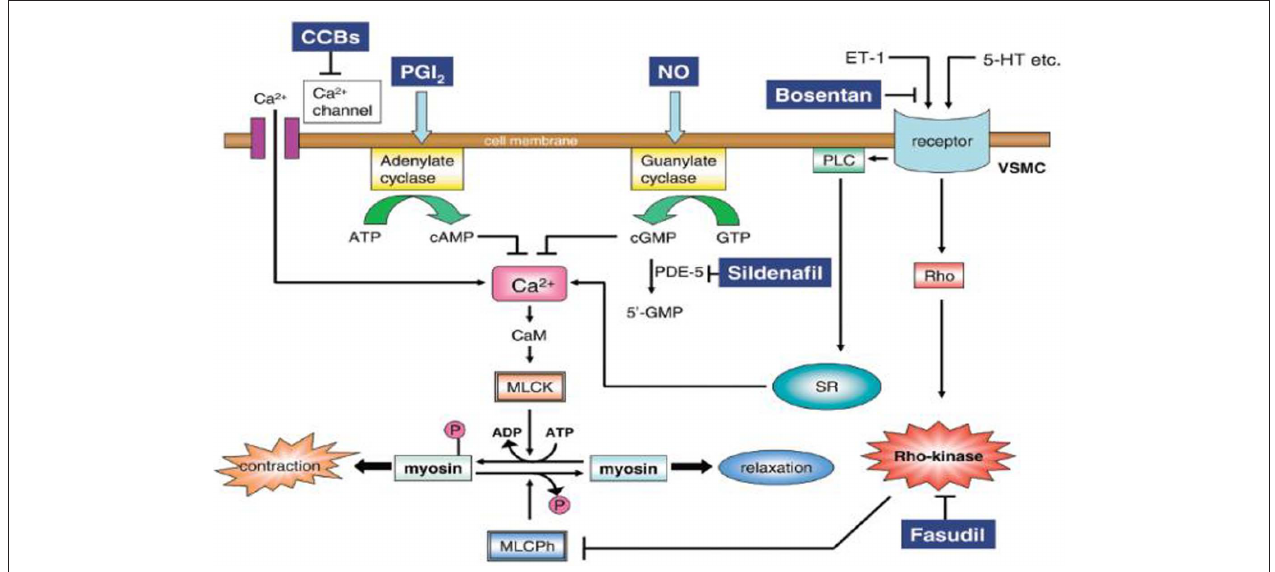
FIGure 4 | Mechanism of pulmonary dilatation in response to some specific drugs and rho-kinase inhibitors. 5-HT, serotonin; CaM, calmodulin; CCBs, calcium channel blockers; ET-1, endothelin-1; MLCK, myosin light chain kinase; MLCPh,